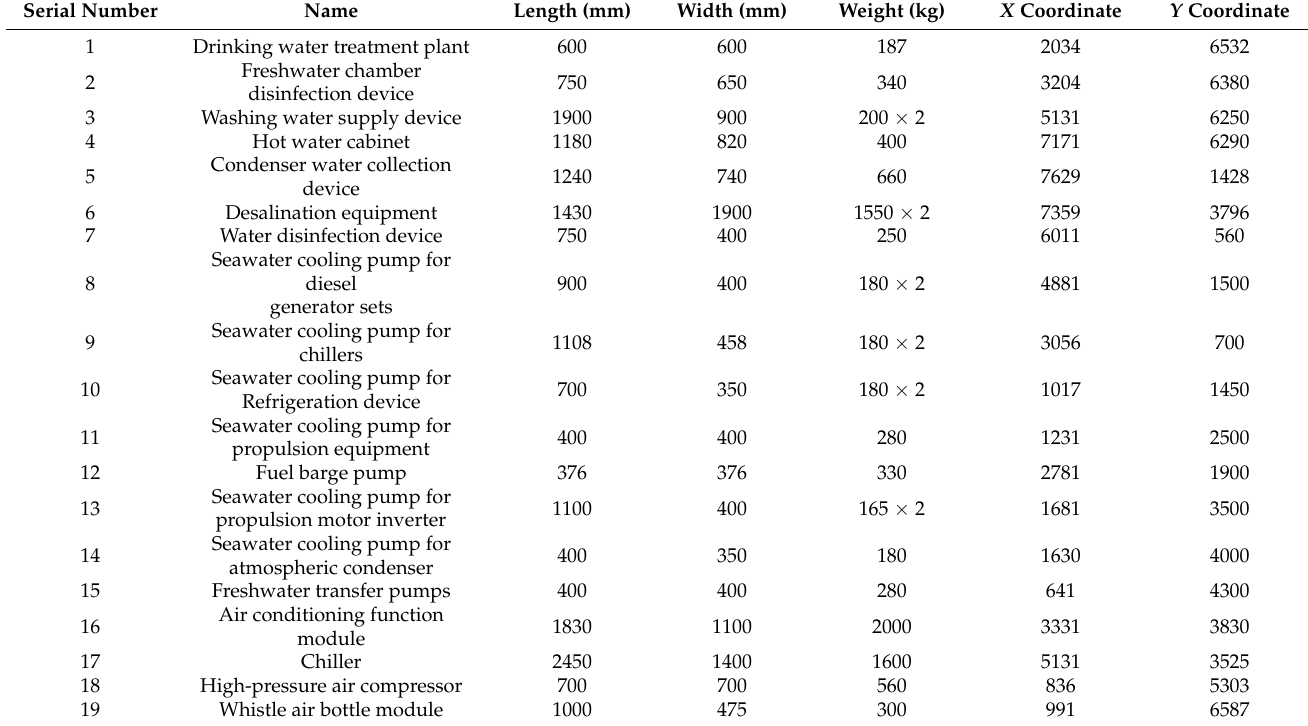
Table 6. Parameters of equipment name, size and weight in the